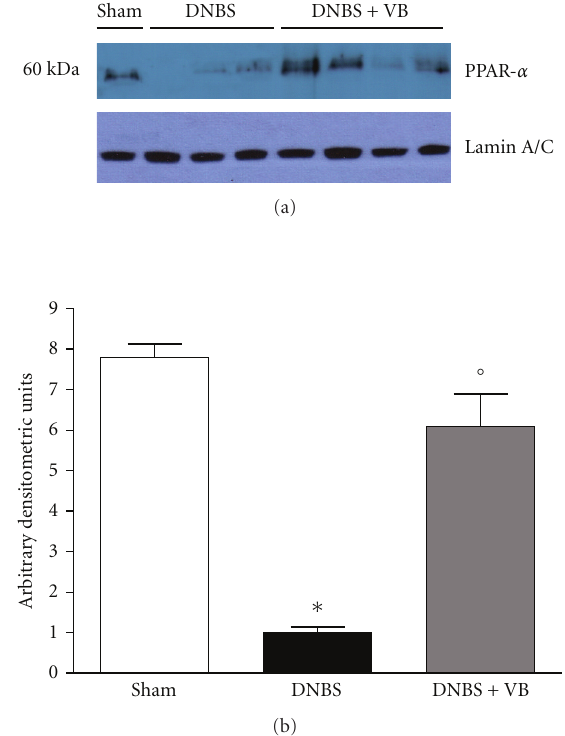
Figure 1: Western blot analysis for PPAR- α in nuclear extracts. By Western blot analysis, a basal level of PPAR- α expression was detected in colon tissues from sham-operated mice ((a) and (b)). Four days after DNBS administration, PPAR- α expression was significantly reduced. VB treatments significantly reduced the DNBS-induced inhibition of PPAR- α expression. The relative expression of the protein bands was standardized for densitometric analysis to lamin A/C levels and reported in (b) expressed as mean ± s.e.m. from n = 5 / 6 colon for each group. ∗ P < . 01 versus Sham; ◦ P < . 01 versus DNBS-WT